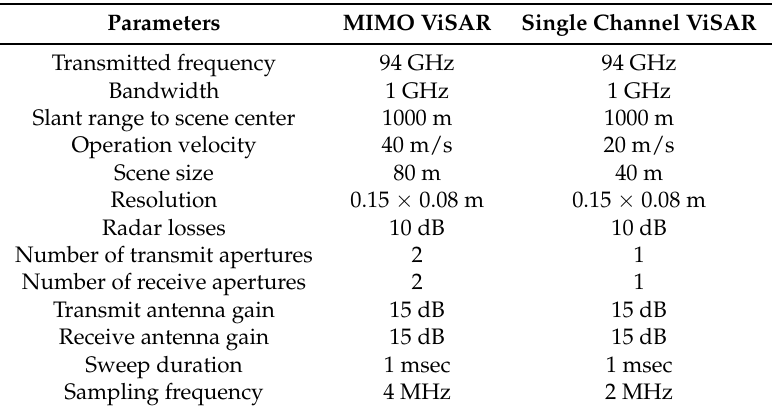
Table 1. System parameters. ViSAR: video synthetic aperture